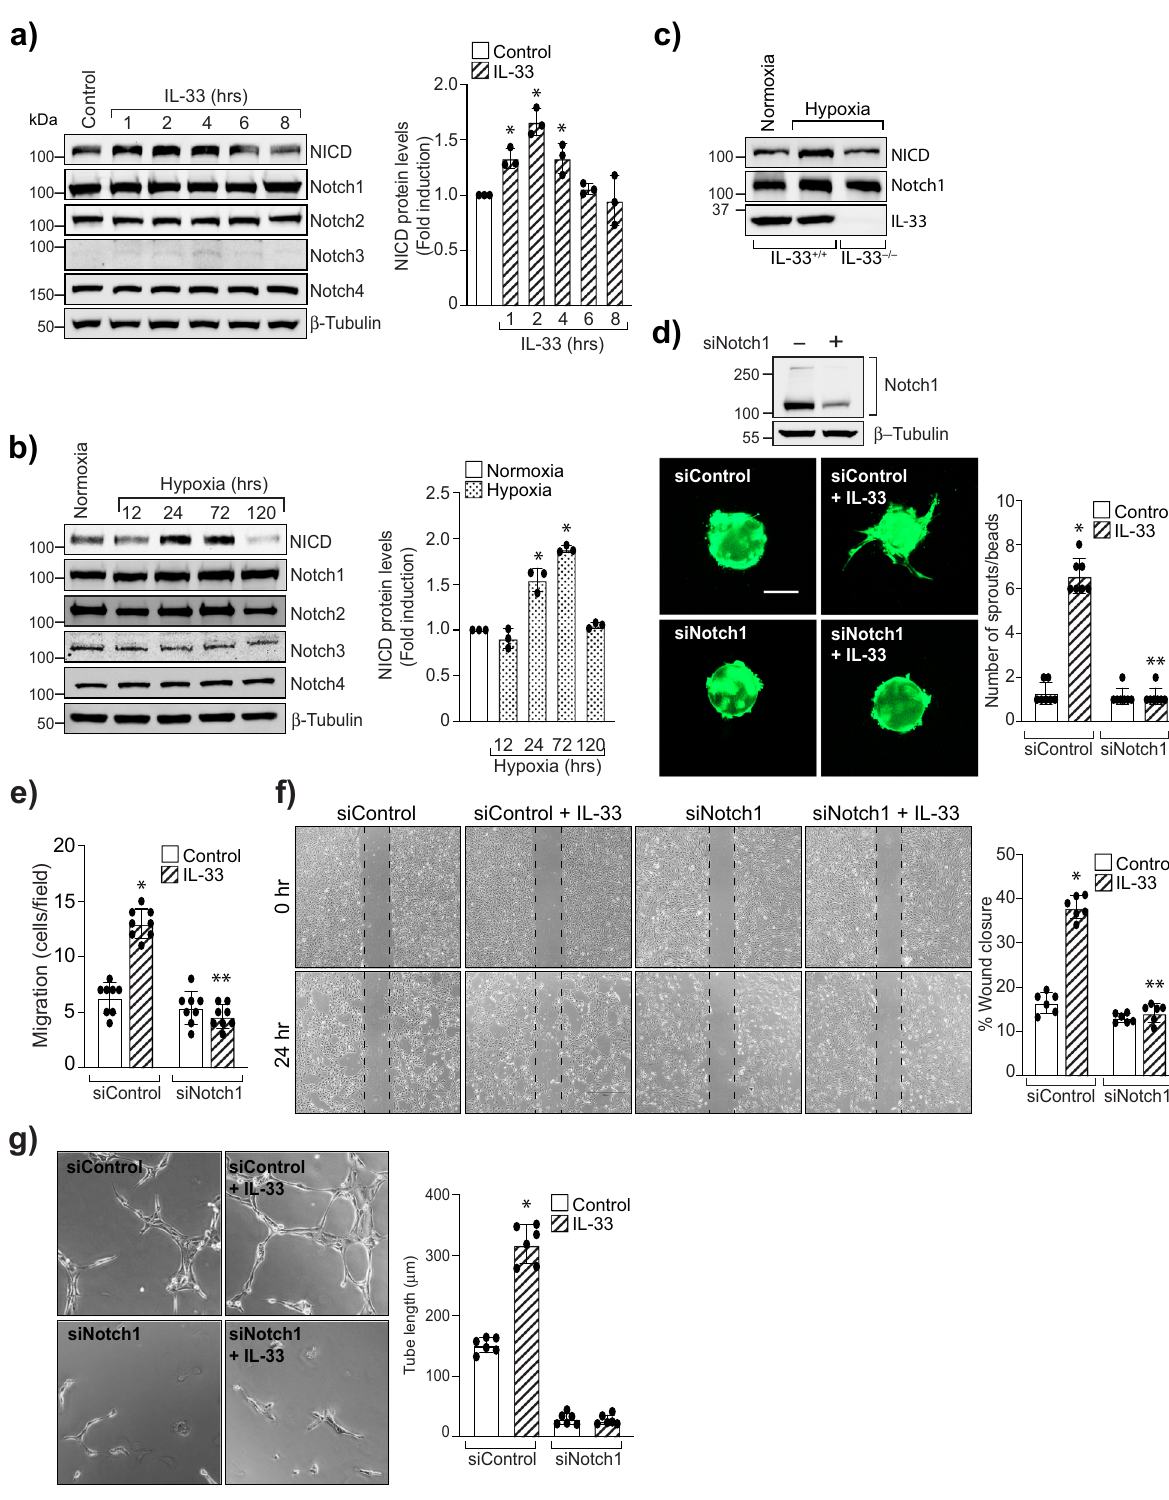
Fig. 7 Notch1 activation mediates IL-33-induced angiogenic effects. a Quiesced HRMVECs were treated with and without IL-33 (20 ng/mL) for various time periods and analyzed by Western blotting for Notch1 intracellular domain (NICD), Notch1, Notch2, Notch3, Notch4 levels and normalized to β -tubulin. b Retinal extracts of C57BL/6 mice pups from normoxia and various time periods of hypoxia were analyzed for the indicated proteins by Western blotting and normalized to β -tubulin. c At P15, retinal extracts from IL-33 + / + and IL-33 − / − mice pups were analyzed by Western blotting for indicated proteins. n = 6 animals per group. d Upper panel, HRMVECs were transfected with control (siControl), or Notch1 siRNA (siNotch1), cell extracts were analyzed for Notch1 level by Western blotting and normalized to β -tubulin. Lower panel, all the condition are same as in upper panel, except that the cells were analyzed for IL-33 (20 ng/mL)-induced sprouting. e – g All the condition are same as in upper d , except those cells were subjected to IL-33 (20 ng/mL)-induced migration ( e , f ), and tube formation ( g ). The bar graphs show quantitative analysis of three independent experiments, expressed as Mean ± SD. * P < 0.05 vs control siRNA or normoxia, ** p < 0.05 vs control siRNA + IL-33. Scale bar represents 50 μ m in d